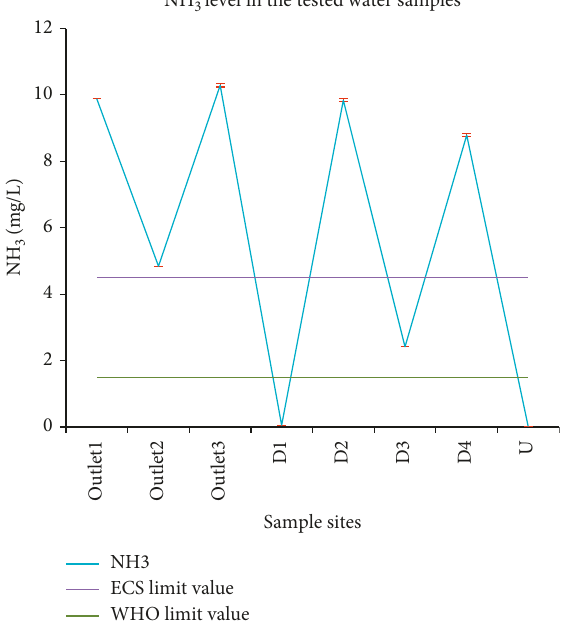
Figure 8: Comparison between the NH 3 level in wastewater from the Zenzelma campus and the ECS and WHO recommended NH 3 discharge limit in industrial